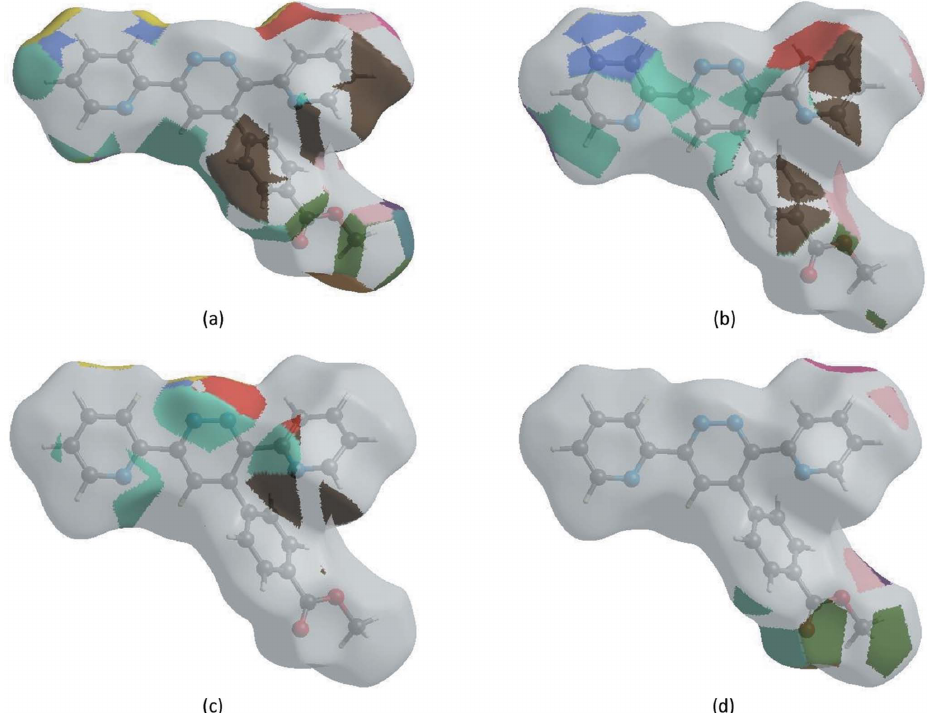
Figure 7 The Hirshfeld surface representations with the function d norm plotted onto the surface for ( a ) H (cid:2)(cid:2)(cid:2) H, ( b ) H (cid:2)(cid:2)(cid:2) C/C (cid:2)(cid:2)(cid:2) H, ( c ) H (cid:2)(cid:2)(cid:2) N/N (cid:2)(cid:2)(cid:2) H and ( d ) H (cid:2)(cid:2)(cid:2) O/ O (cid:2)(cid:2)(cid:2) H